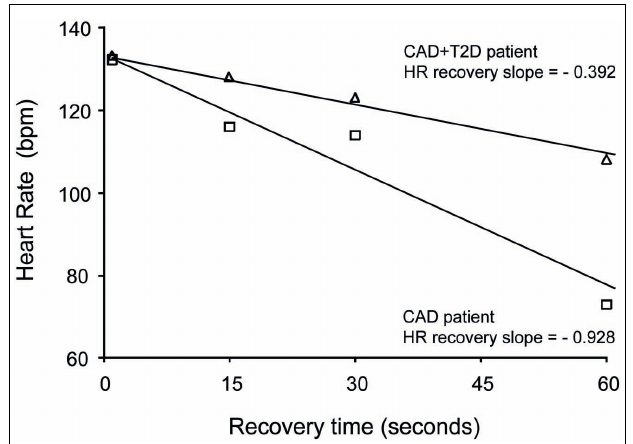
FIGURE 1 | Example of heart rate recovery as the slope of heart rate during the first 60s after cessation of exercise for two patients (with and without type 2 diabetes) with similar age and maximal heart rate. The slope was calculated by linear model using mean values of 5 R–R intervals [converted to the HR values in beats/min as 60 · (mean R–R interval in ms/100) − 1 ] at maximum and around the time points of 15, 30, and 60s after cessation of